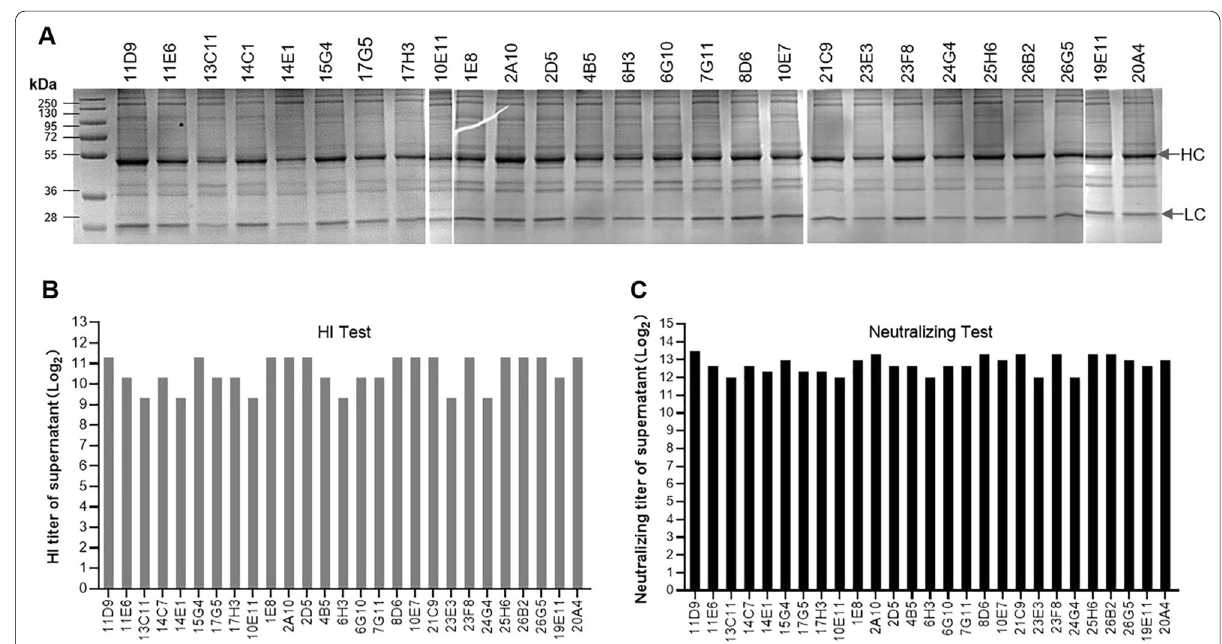
Fig. 5 Constriction of CHO-S cell line with chimeric antibody expression: selection round 2